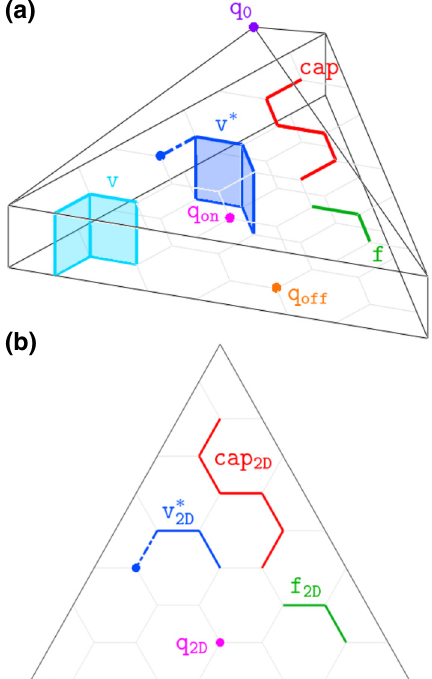
FIG. 11. (a) Examples of faults of each type on the 3D struc- ture. (b) Examples of faults of each type on the 2D